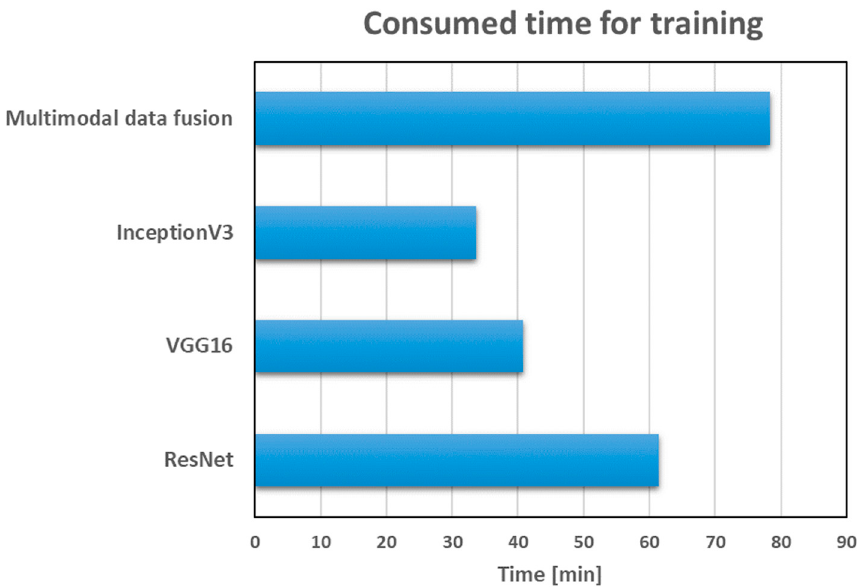
Figure 4. The consumed time for training.